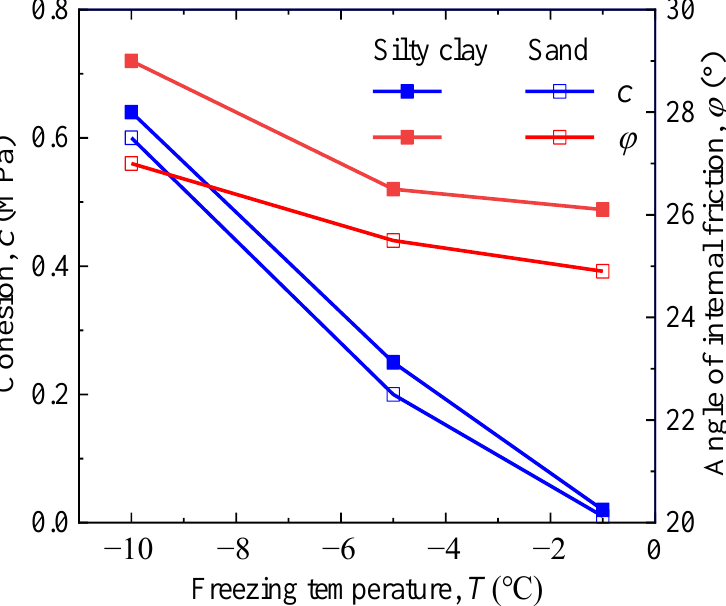
Figure 6. Variation in the cohesion and angle of internal friction versus freezing temperature.